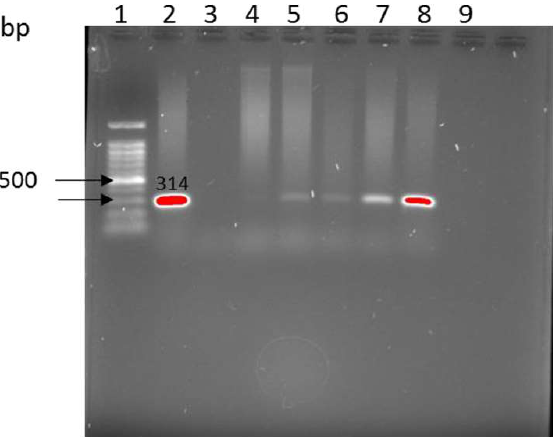
Figure 1. Amplification of the rfbE gene in E. coli O157:H7. Lane 1: 1 kb ladder, lane 2: positive control E. coli O157:H7 ATTC, Lane 3: water negative control, Lane 4–8: samples.